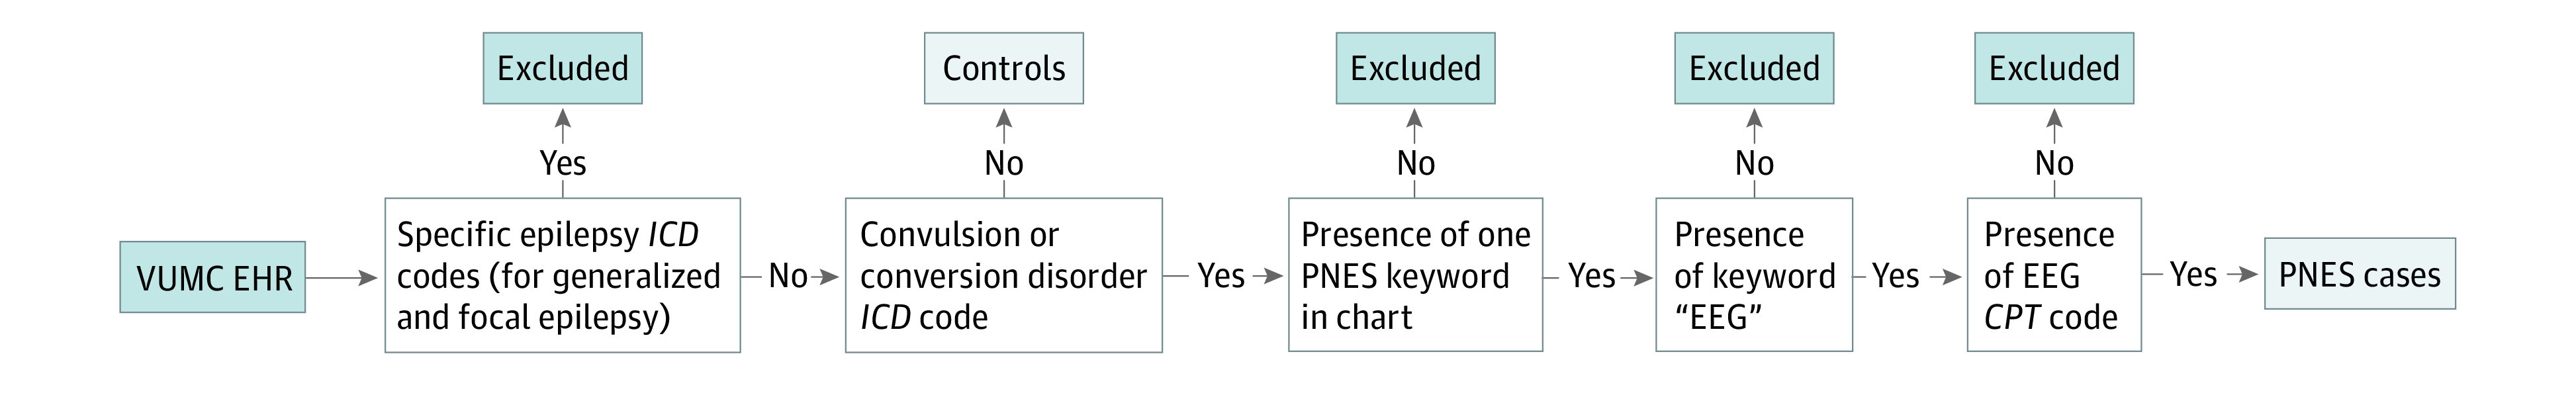
Algorithm for Detecting Functional Seizures Cases and Controls Within the VUMC-EHRAll Vanderbilt University Medical Center electronic health records (VUMC-EHR) were initially included, then anyone with generalized or focal epilepsy International Classification of Diseases, Ninth Revision (ICD-9) and International Statistical Classification of Diseases and Related Health Problems, Tenth Revision (ICD-10) codes were excluded. Patients without convulsion or conversion disorder ICD codes were considered cases, while anyone with both a psychogenic nonepileptic seizures (PNES) keyword in their medical record and the presence of the keyword “EEG” (electroencephalogram) was included as a functional seizures case. CPT indicates Current Procedural Terminology.